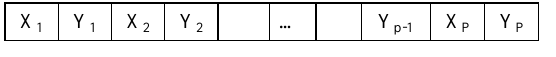
Fig. 3. The structure of a chromosome for external GA The value of objective function for external genetic algorithm is the calculated value of Eq. (10), which is the optimum value of internal